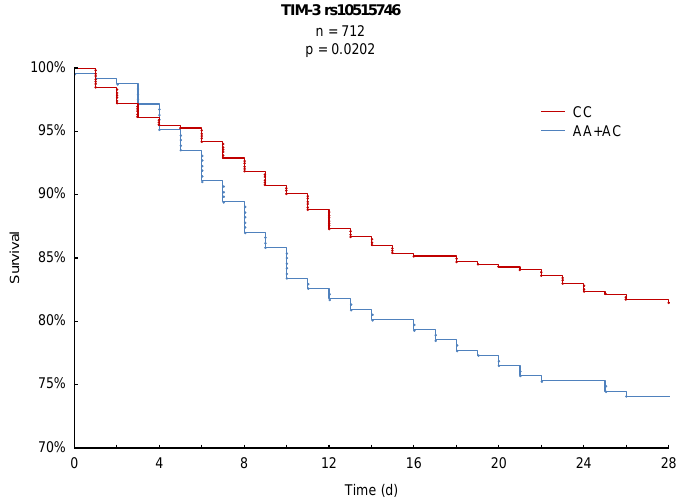
Figure 2. Kaplan–Meier 28-day survival analysis with respect to TIM-3 rs10515746.